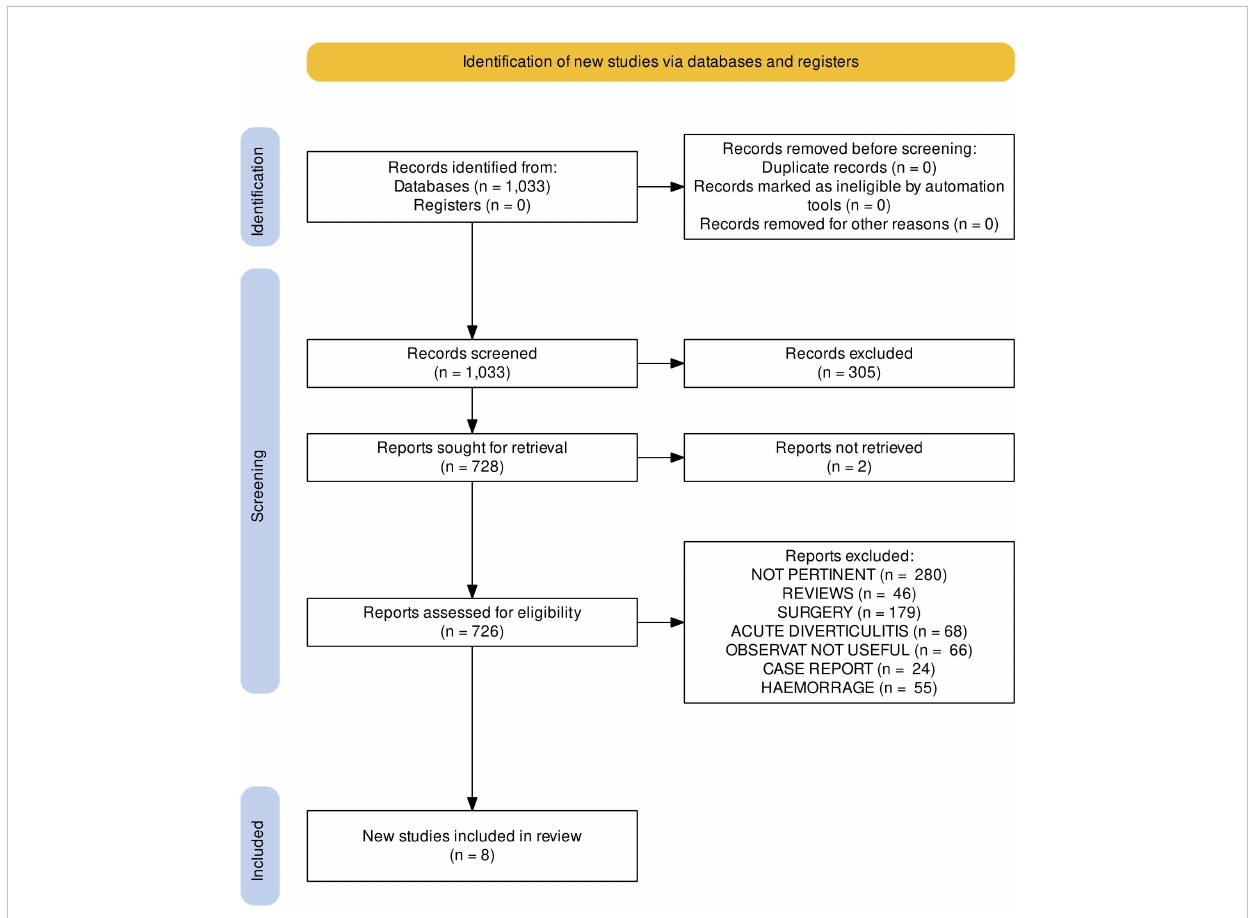
FIGURE 1 PRISMA fl ow diagram, according to PRISMA 2020